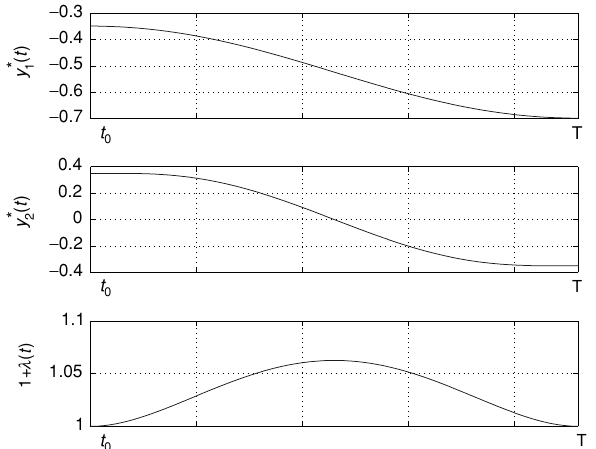
Figure 2 Path planning for y ∗ row); Function f ( t ) = 1 + λ (t) (third row).